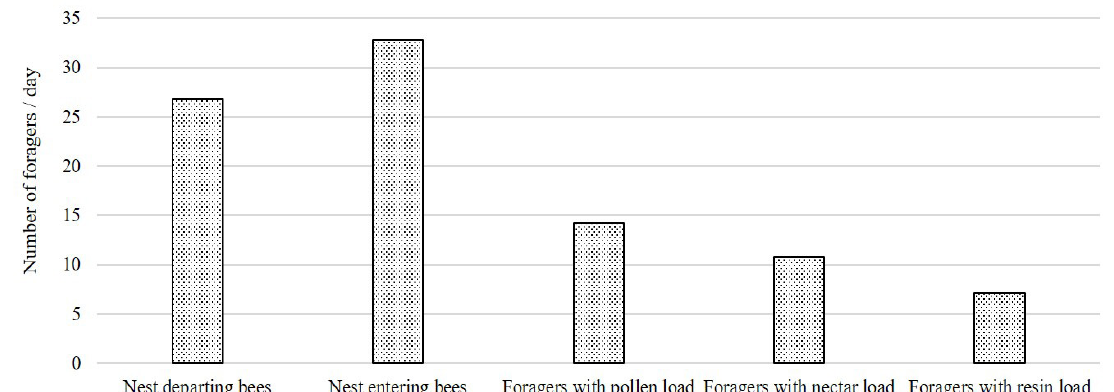
Fig 1. Foraging activity of bees after acceptance of coconut shell